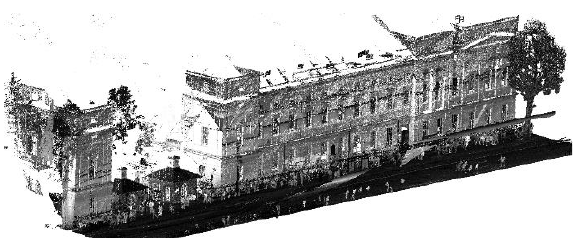
Figure 6: Detail view of the medium size data set used in the experiment.